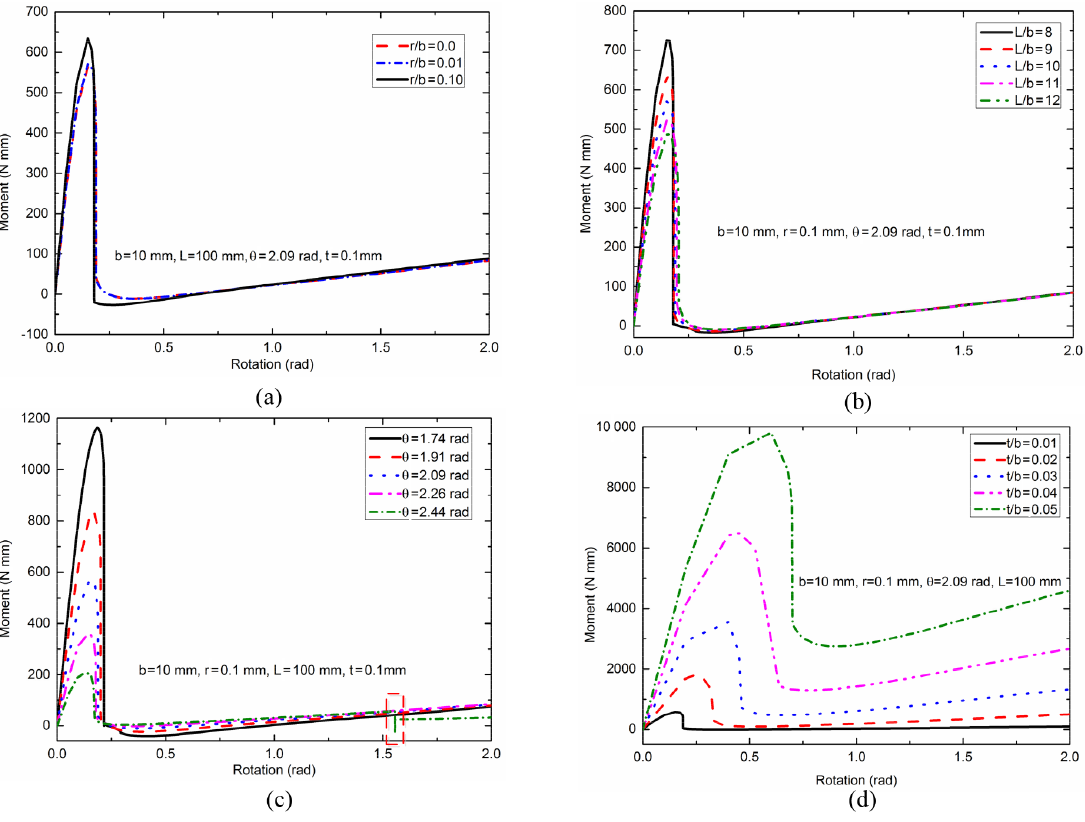
Figure 6. Moment-rotation relationship obtained from finite element modellings showing the influences of nondimensional geometrical parameters of the strips on the mechanical responses: (a) r /b , (b) L/b , (c) θ , and (d) t /b